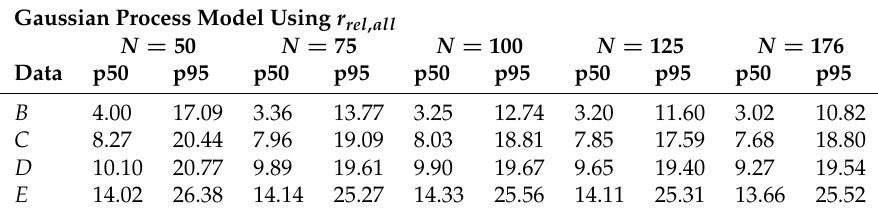
Table 8. The p50 and p95 percentiles of the error expressed in (cm) for the Gaussian process model for the second relative RSS scheme.